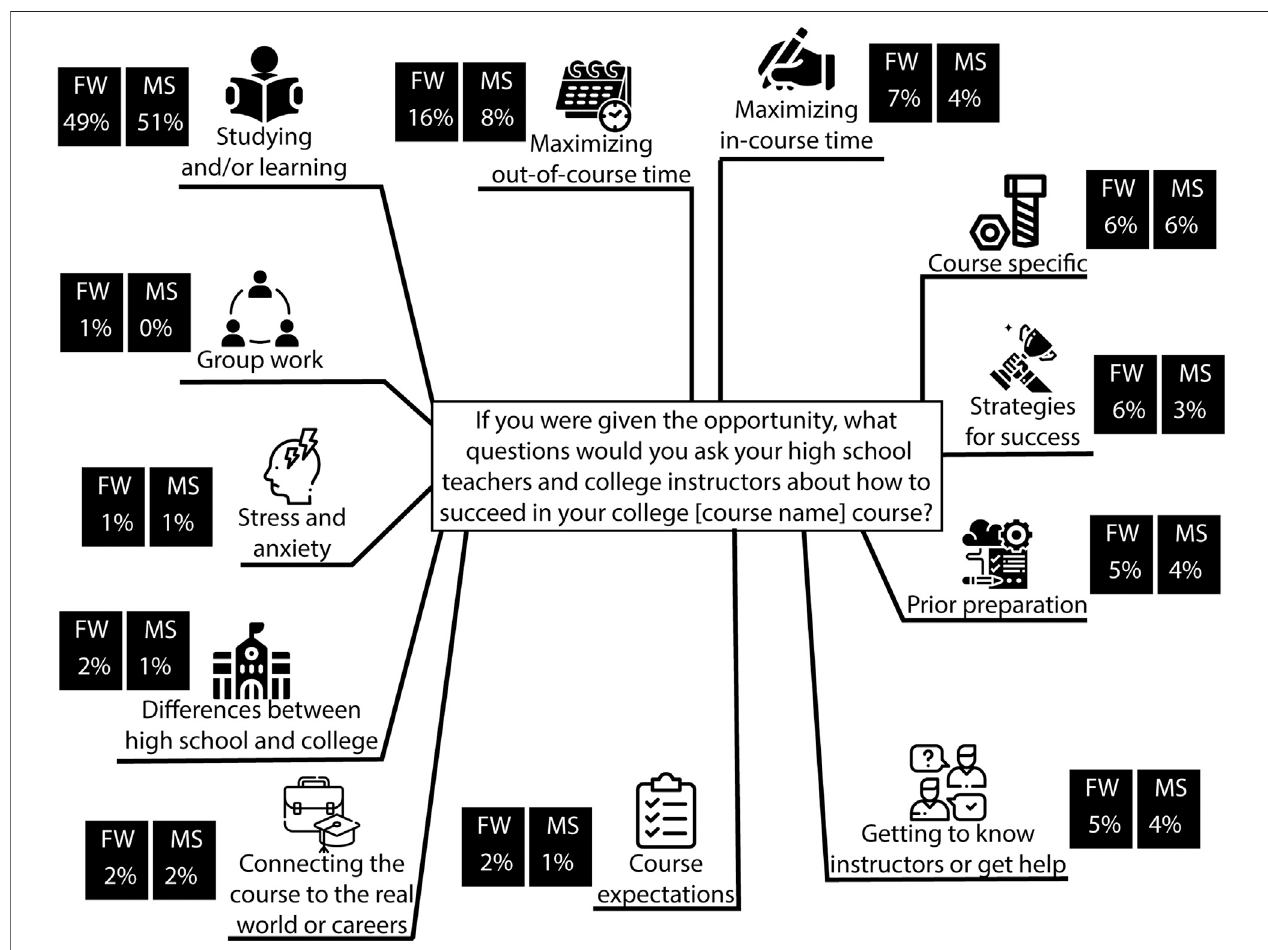
FIGURE 1 | Categoriesofstudentquestions.Thediagramoutlinestwelvecategoriesofstudentquestions,addressingthepromptinthecenteroftheweb.Thepercentof studentresponsesaskingquestionswithineachcategoryisprovidedintheblackboxesdesignated “ FW ” ( fi rst-week)and “ MS ” (mid-semester).Categoriesarearrangedclockwise frommostcommonduringthe fi rstweektoleastcommonduringthe fi rstweekbeginningintheupperleftcorner.Twocategories, “ uncategorized ” (responsesthatwereoff-topic, orwerestatementsandnotquestions:4%ofstudentresponsesduringthe fi rstweek;6%ofresponsesmid-semester)and “ none,NA,notsure ” (12%ofstudentresponses duringthe fi rstweek;18%ofresponsesmid-semester)arenotincludedinthediagram,asthecategoriesareuninformativeforinstructorsplanningresponsestoquestions.Icons designed by Eucalyp, Freepik, fjstudio, monkik and Kiranshastry and obtained from www. fl